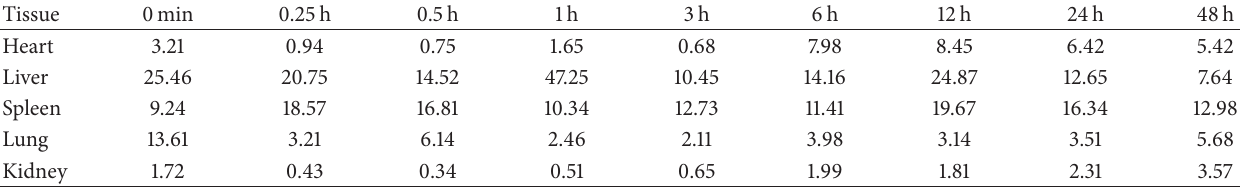
O nanoparticles in mice at different sampling points (%, ID/g, 𝑛 = 6 ). 3 4